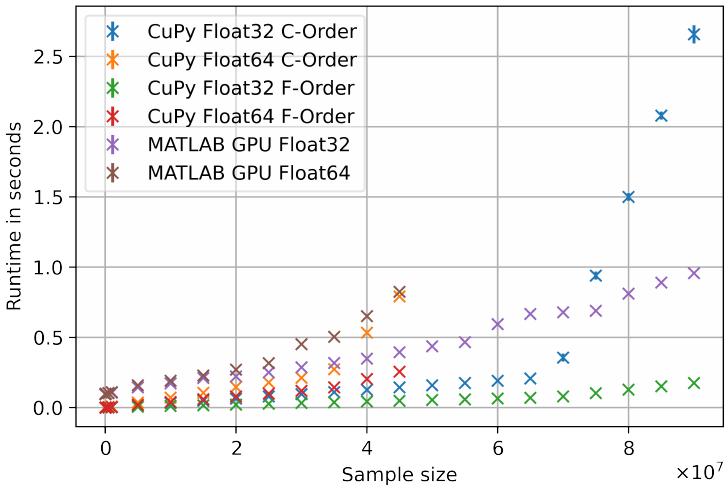
Figure 7. Statistical tolerance analysis using GPU: Mean runtime results with error bars. Table 8. Statistical tolerance analysis using GPU: Mean runtime results in seconds with standard error of the mean. Sample